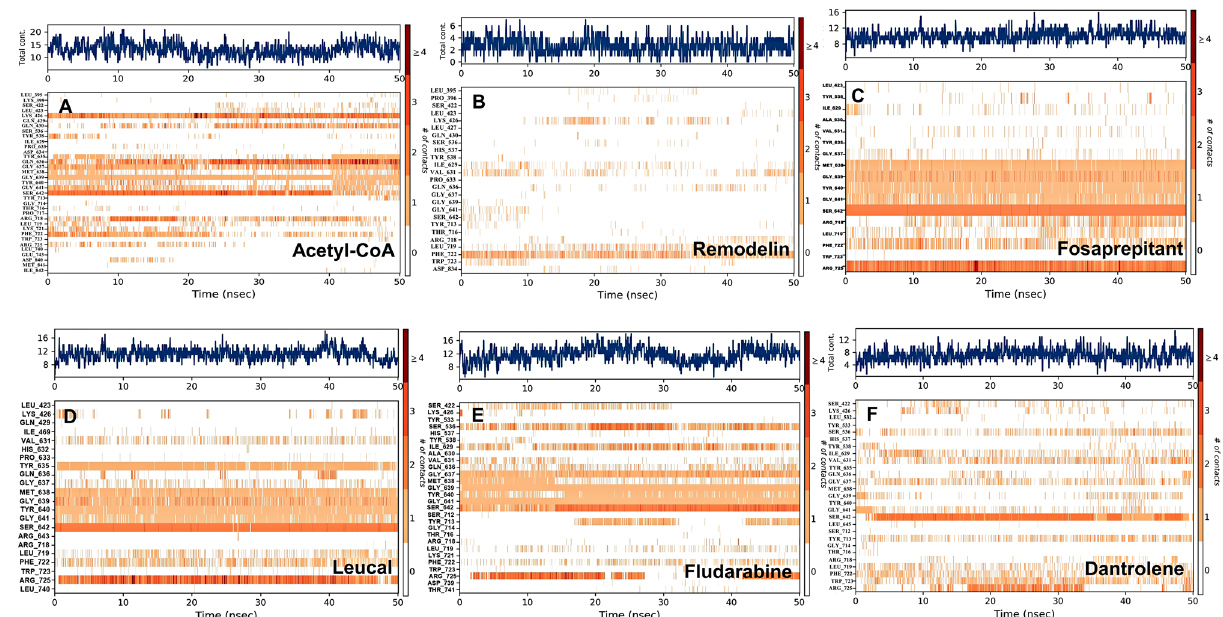
Figure 5. Interaction of each residue of the acetyl-CoA binding pocket with ligands in each trajectory frame. ( A ) Acetyl-CoA ( B ) Remodelin ( C ) Fosaprepitant ( D ) Leucal ( E ) Fludarabine ( F ) Dantrolene. Deeper coloration corresponds to more contact between ligands and